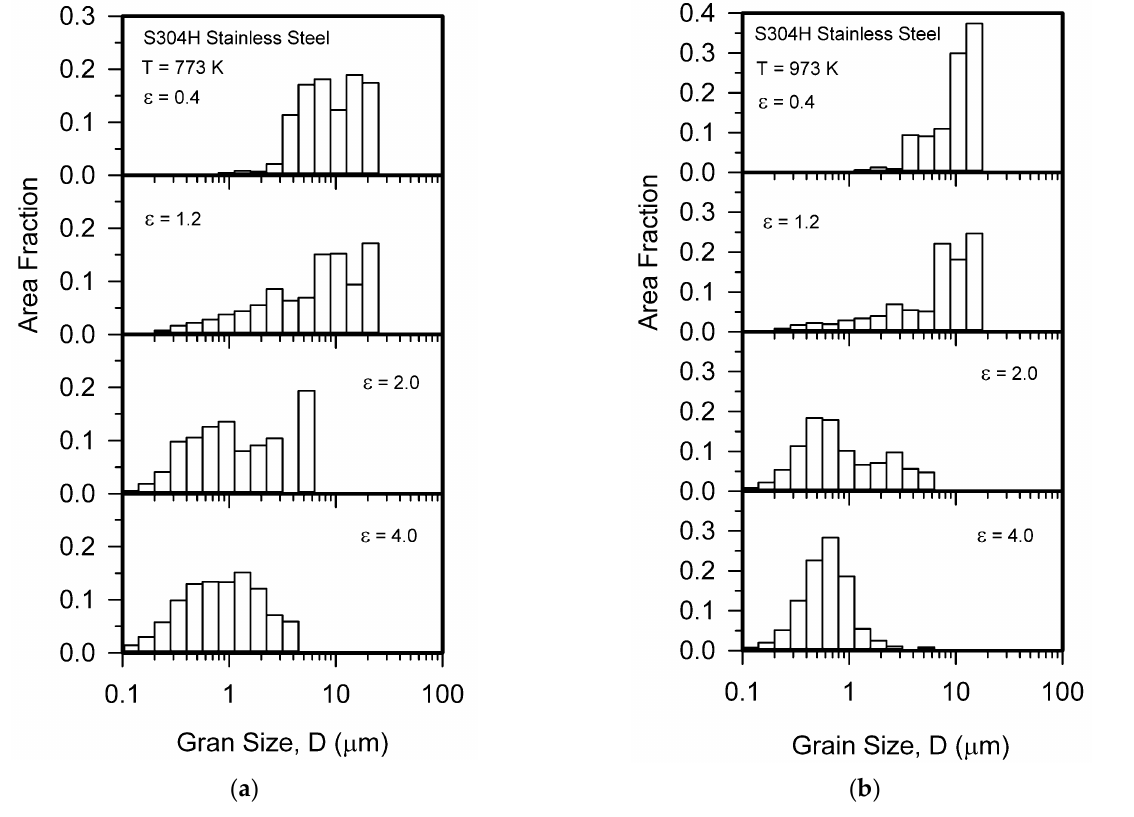
Figure 11. Grain size distributions developed in a 304-type stainless steel after multiple forging to indicated strains at 773 K ( a ) or 973 K ( b ) [70].